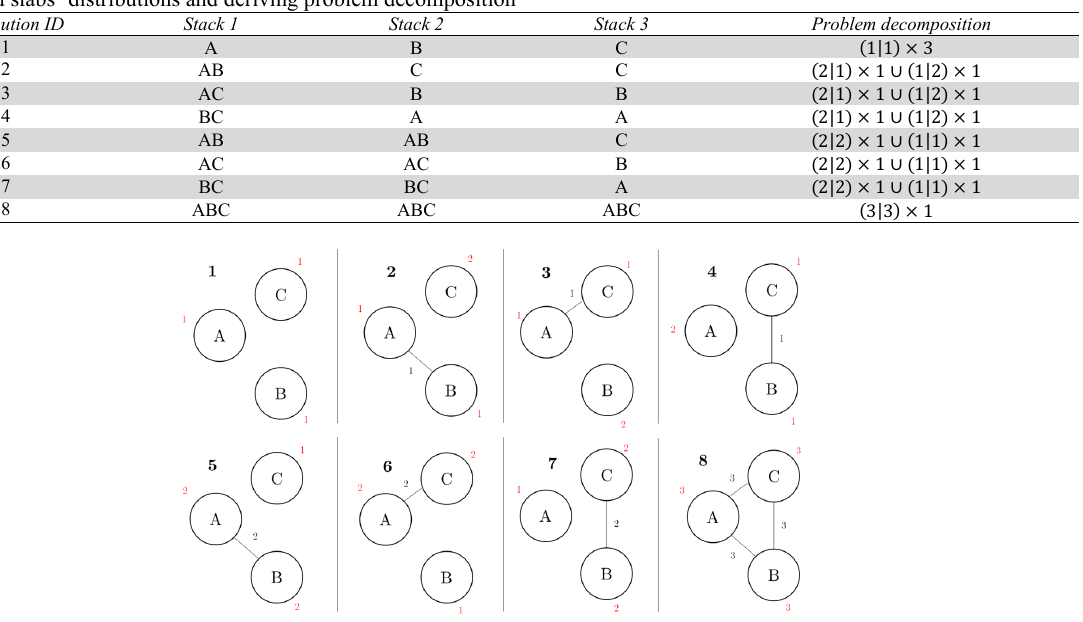
Fig. 7. The underlying graphs of the yard by slabs’